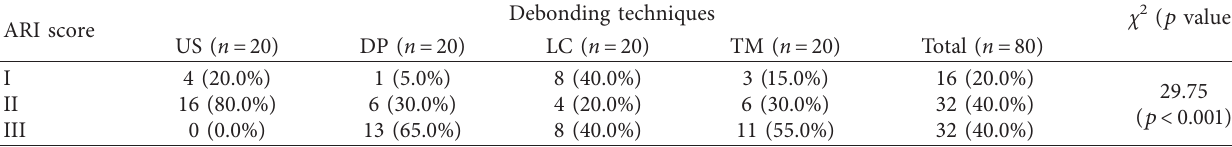
Table 3: Adhesive Remnant Index for the methods used.